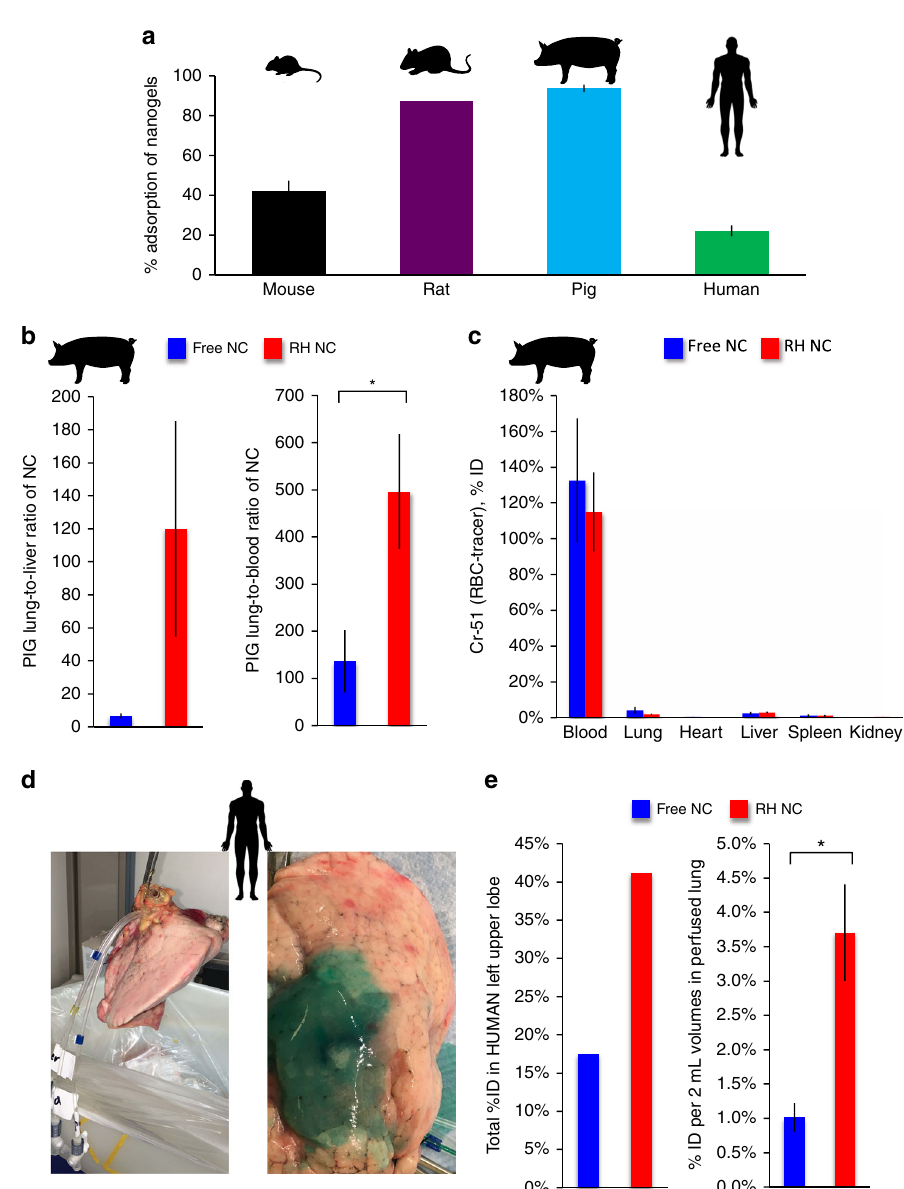
Fig. 5 RH works in large animals and ex vivo human lungs. a Adsorption ef fi ciency of nanogels onto various species ’ RBCs. Each data point represents mean ± s.e.m ( n = 3 replicates per condition). b Live pigs were injected with I-125-labeled nanogels that were either free or RH. Plotted are the lung-to-liver and lung-to-blood ratios. Each data point represents mean ± s.e.m ( n = 3 pigs per condition). c Safety in pigs was assessed by showing that Cr51-labeled RBCs used in the RH experiments of b did not get stuck in the lungs. d , e Ex vivo human lungs were endovascularly cannulated and then infused through a single artery sequentially with: I-125-labeled RH nanogels; I-131-labeled free nanogels; and a green tissue dye. The percent of the injected dose of the entire lung lobe ( e , left panel) and within only the well-perfused (green) zone ( e , right panel, where ten 2-mL volumes of lung were measured and their mean ± s. e.m. listed on the plot). * P < 0.05, two-tailed t